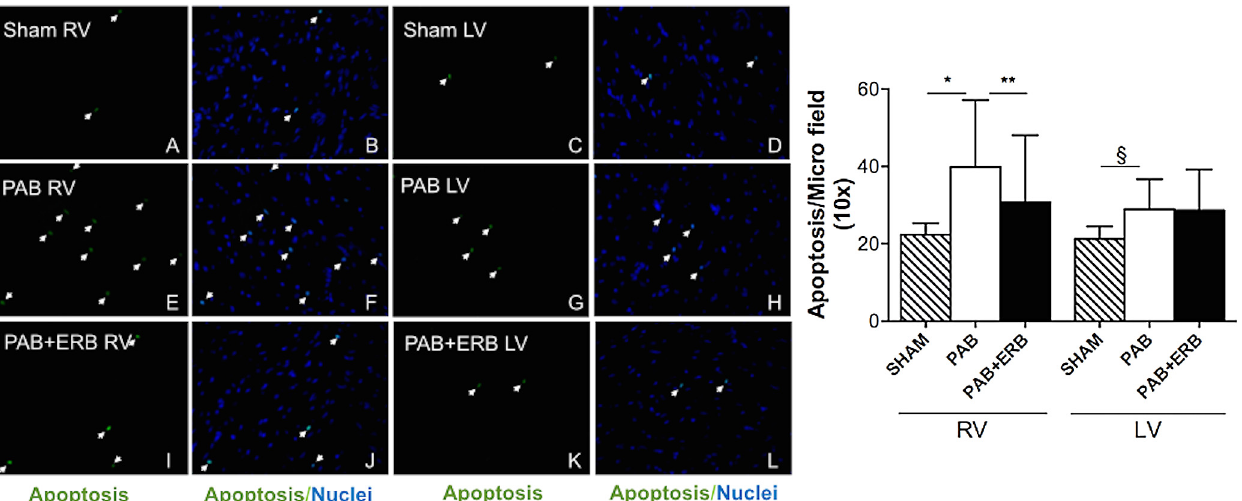
Fig 8. TUNEL results of myocardial apoptosis. A) Apoptosis measured by TUNEL assay in sham operated controls (n = 3), in response to pulmonary arterial banding (PAB, n = 3) and endothelin receptor blocker (ERB, n = 4) treatment at 6-weeks after PAB. TUNEL analysis of myocardium from sham RV (A, B), LV(C, D); PAB RV (E, F), LV(G, H); PAB with ERB treatment RV (I, J), LV (K, L) rats heart. Arrows show apoptotic nuclei indicated by green (A, C, E, G, I, K). Blue spots represent nuclear stained by DAPI (4',6-diamidino-2-phenylindole dihydrochloride) and merged images are shown in B, D, F, H, J and L (magnification ×400). B) Bar graph with quantification of apoptosis in the right and left ventricles. In the right ventricle apoptosis increased with PAB compared to sham ( * p (cid:1) 0.0001) and diminished with macitentan (compared with PAB ** p (cid:1) 0.05). For the LV, apoptosis increased with PAB compared